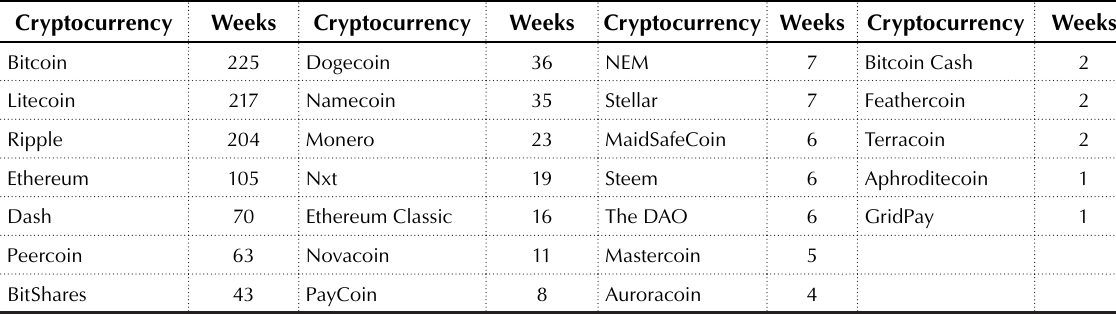
Table 1. Components of the cryptocurrency index as of August 13,